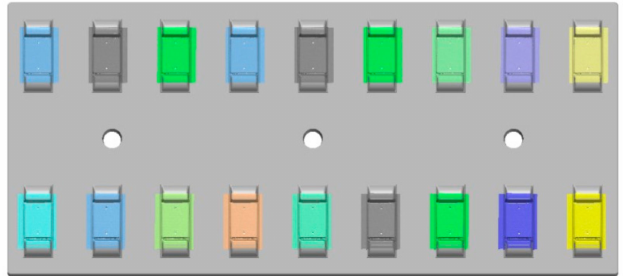
Figure 10. Results of point cloud and model registration results.